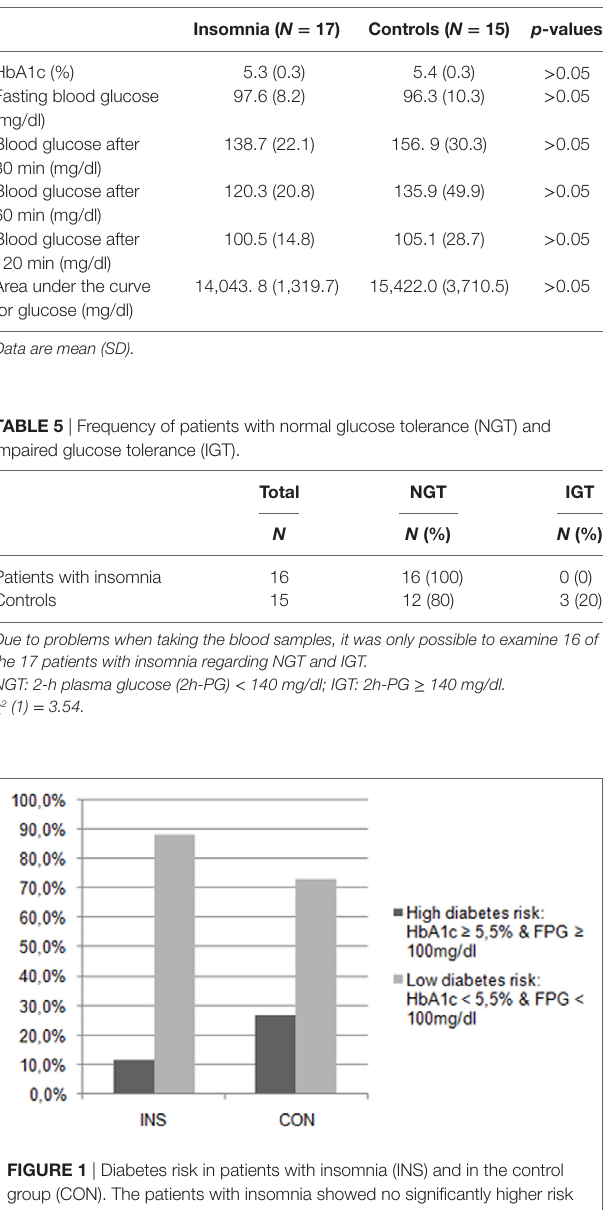
TaBle 4 | Glucose